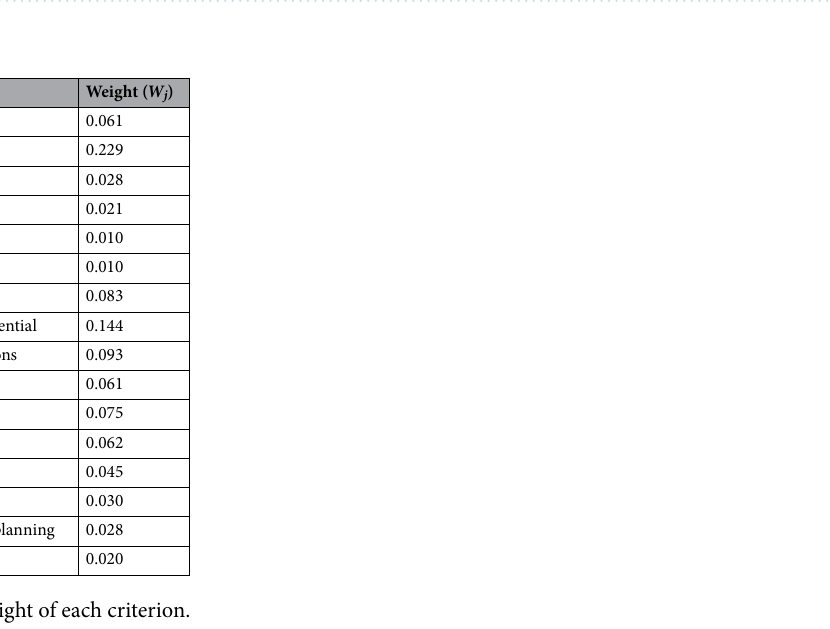
Table 3. Rules of transforming regular numbers into triangular fuzzy numbers 60 .